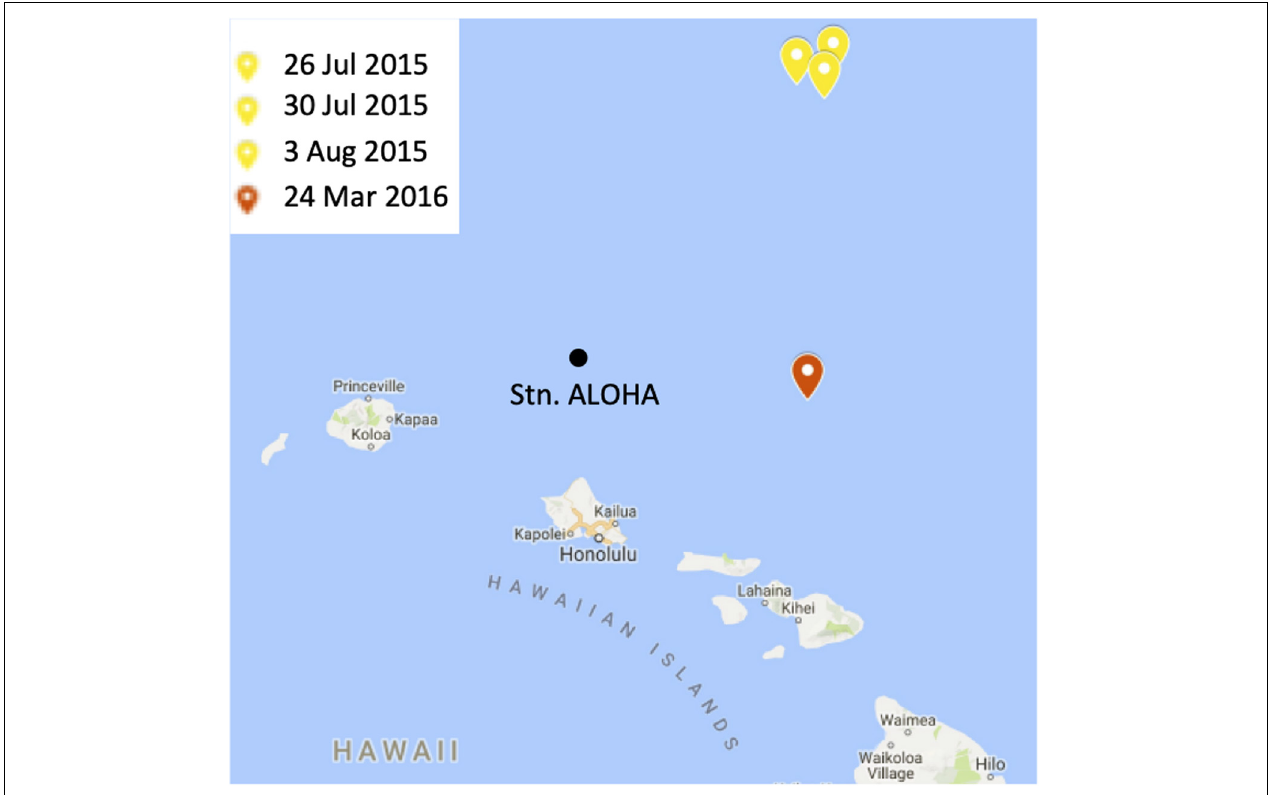
FIGURE 2 | A map of the study site. The locations and dates of sampling during the summer 2015 and spring 2016 cruises are indicated in yellow and red, respectively. Station ALOHA is shown for context. The figure was made in Microsoft PowerPoint 2013 by modifying Hawaiian Islands Google Map (Map data ©2019, Google).